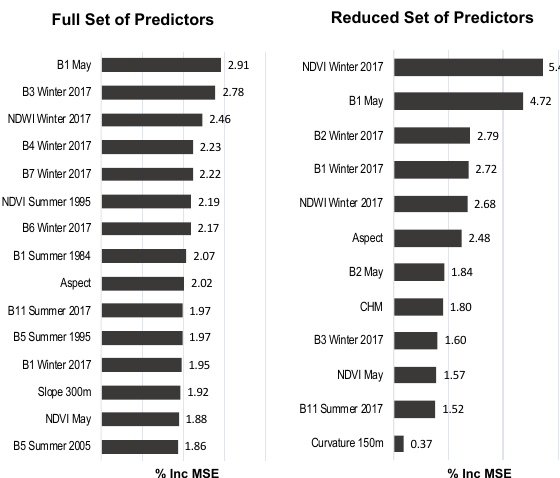
Figure 4. The gray line denotes a perfect prediction,